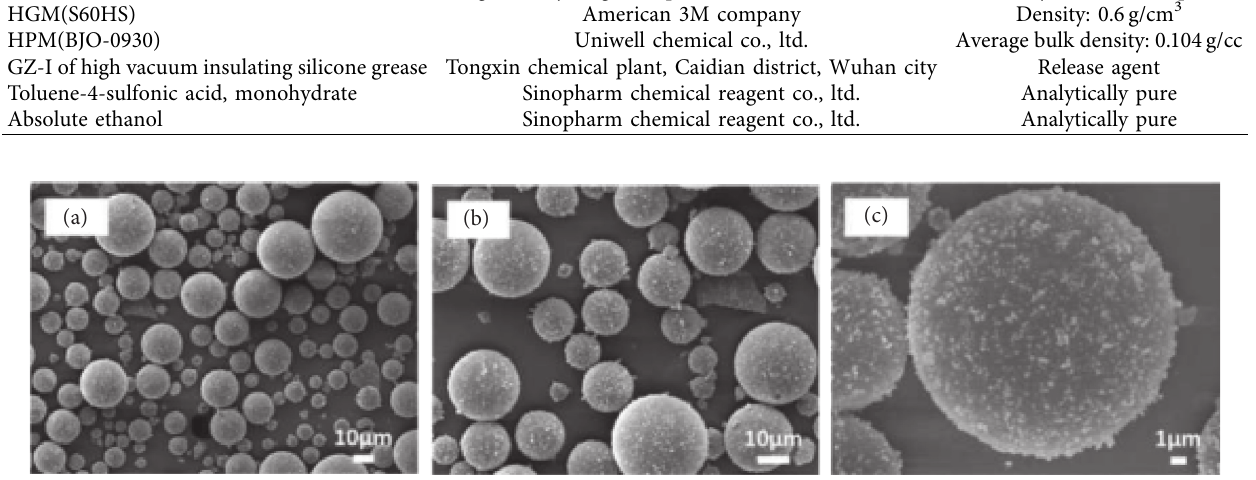
Figure 1: (a) SEM image of hollow glass microspheres under 500 times magnification; (b) SEM image of hollow glass microspheres under